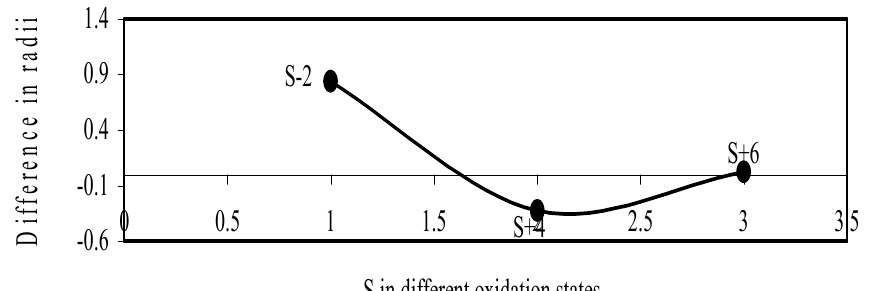
Figure 10. Plot of difference in experimental and theoretical radii of S in different oxidation